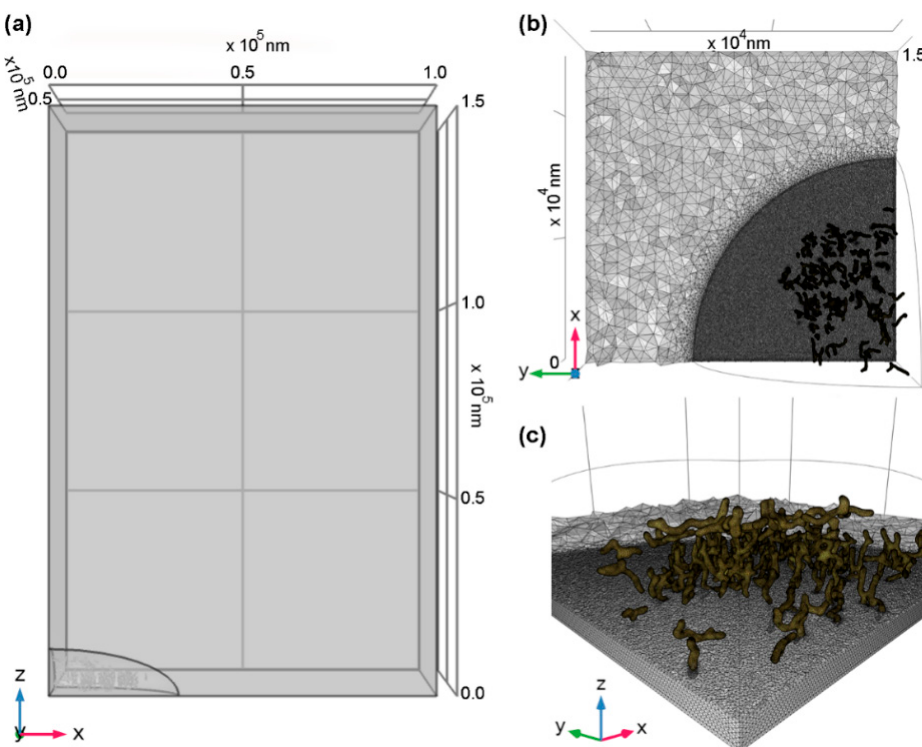
Figure 2. ( a ) Model geometry viewed in profile; ( b ) cross-section of mesh viewed from above and ( c ) center. Rectangular volume defines a column of medium with eighth section of an ellipsoid defining the cytoplasm and live-cell imaged mitochondrial geometry (in gold for meshes). Boundary conditions are as described in Section 4.